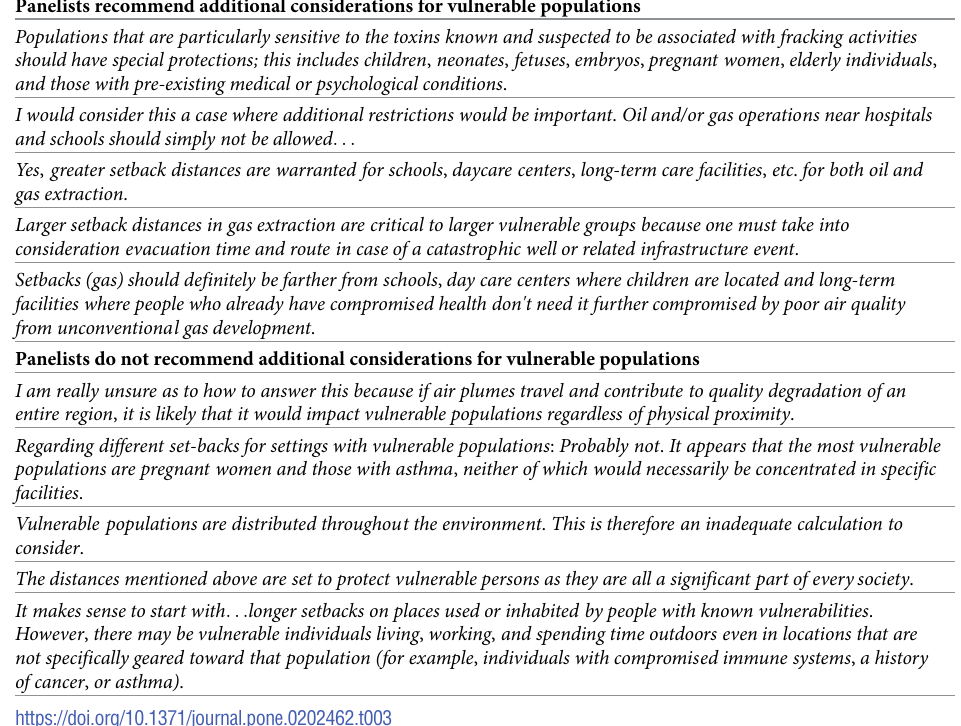
Table 3. A comparison of exemplar statements recommending additional setback distances for vulnerable popu- lations and exemplar statements not recommending additional setback distances for vulnerable populations. Panelists recommend additional considerations for vulnerable